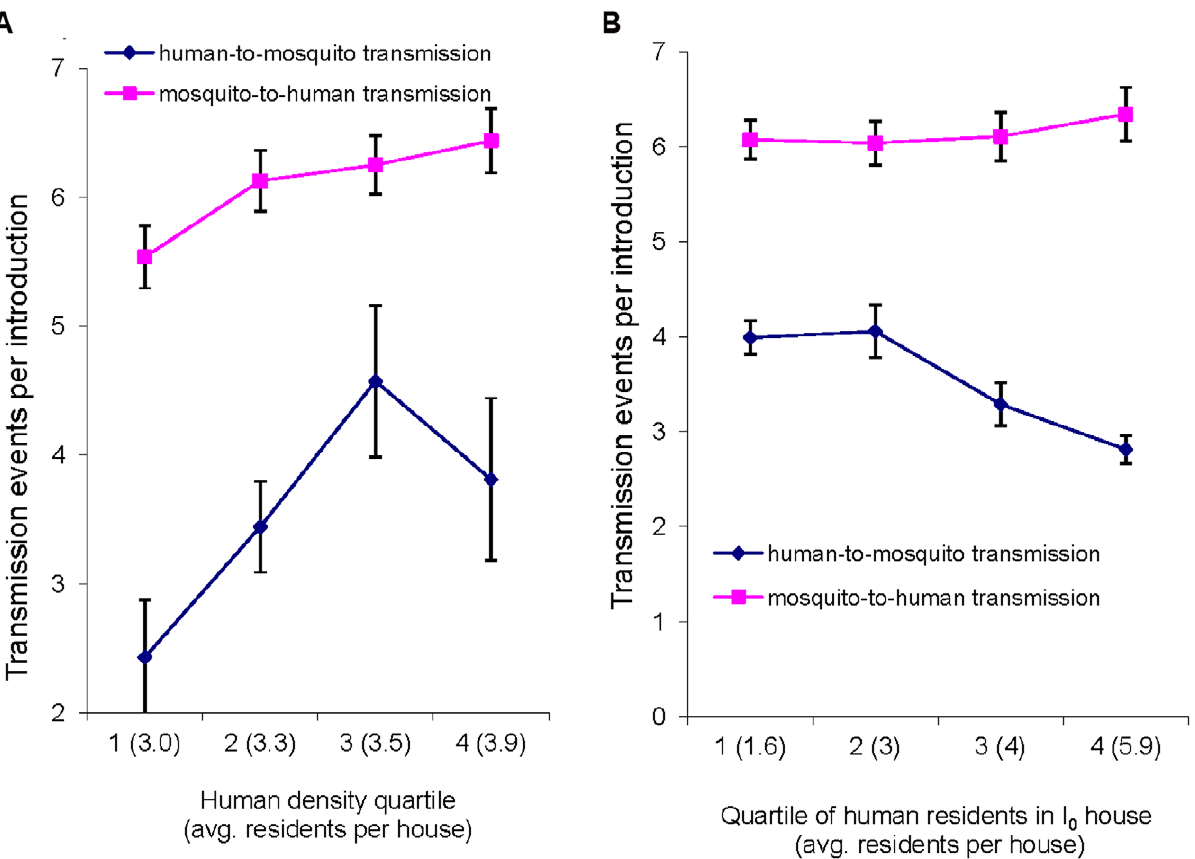
Figure 6. Human density and transmission events (mosquito-to-human and human-to-mosquito transmission). (a) Effects of patch- wide human density (total residents divided by houses); (b) Effects of density of residents in the house of the initial human infection ( I 0 ). Error bars are